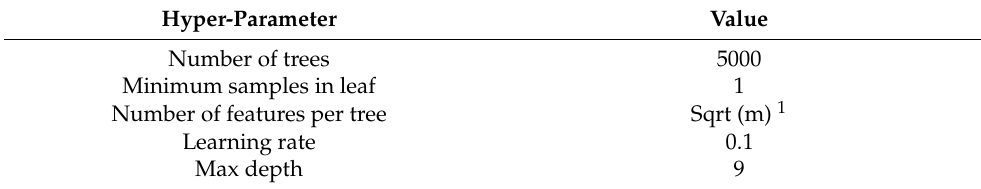
Table 1. Optimal hyper-parameters of the gradient boosting classifier.